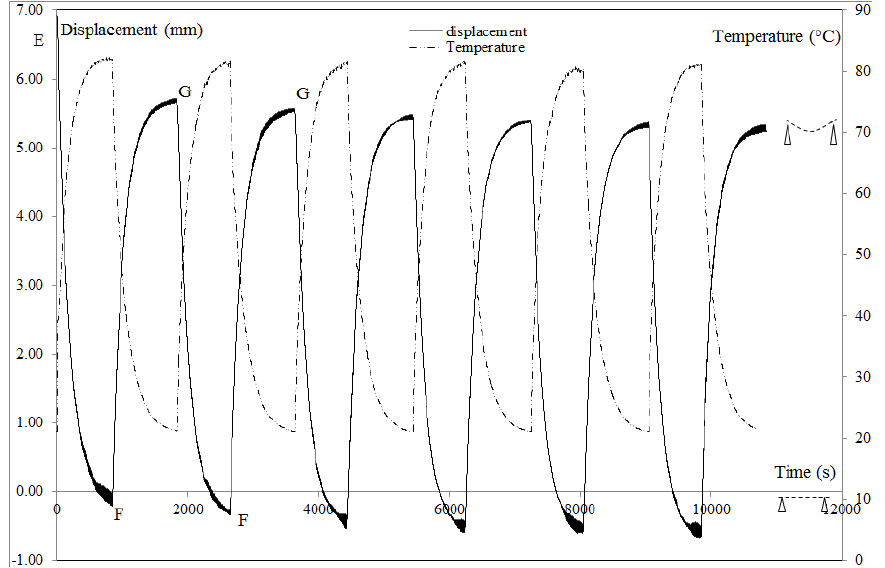
= 80 °C, d I = 6.93 ± 0.93, (ε I = 2.31% ± 0.31%). EF, GF: R F F . Loading equal to the preload of 0.3 a